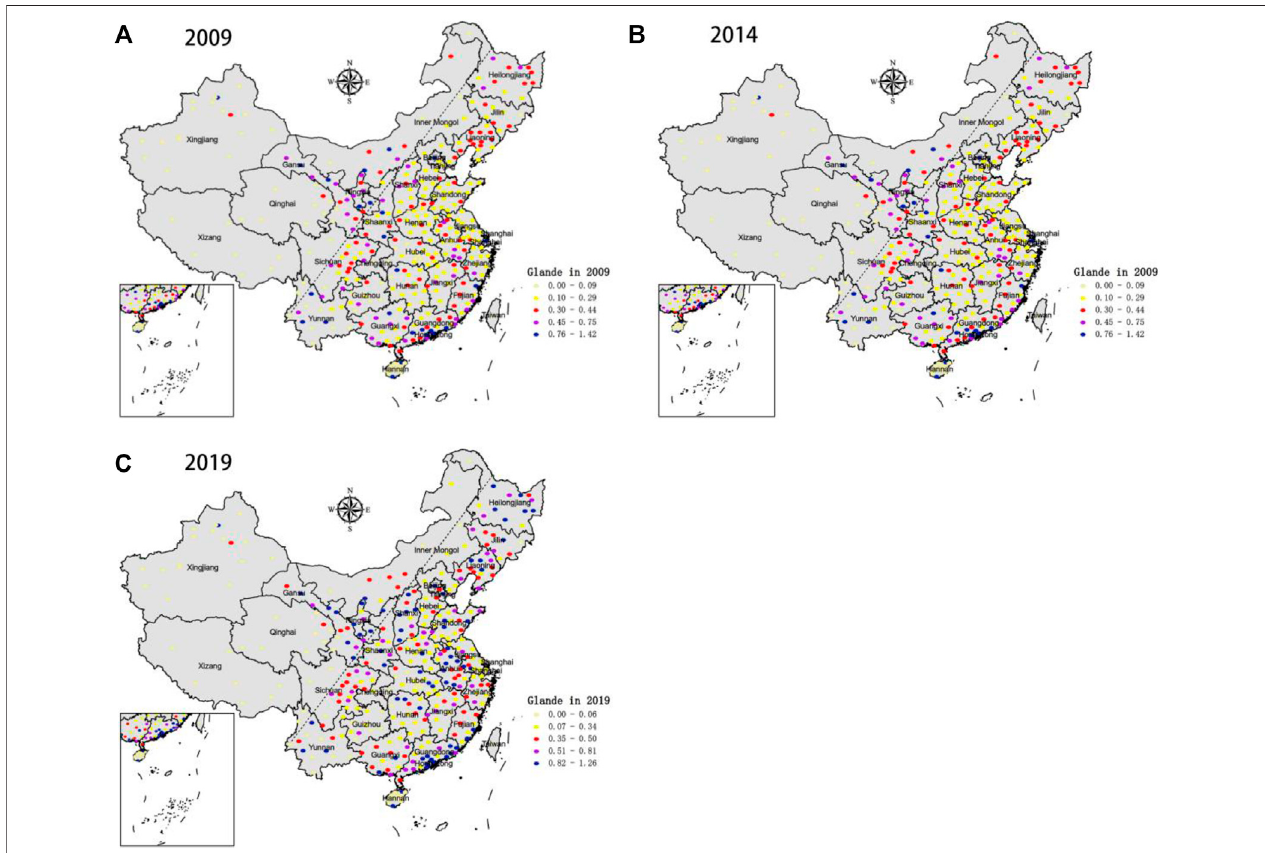
FIGURE 2 | Distribution of Glande in China. (A) Distribution of Glande in China in 2009. (B) Distribution of Glande in China in 2014. (C) Distribution of Glande in China in 2019.